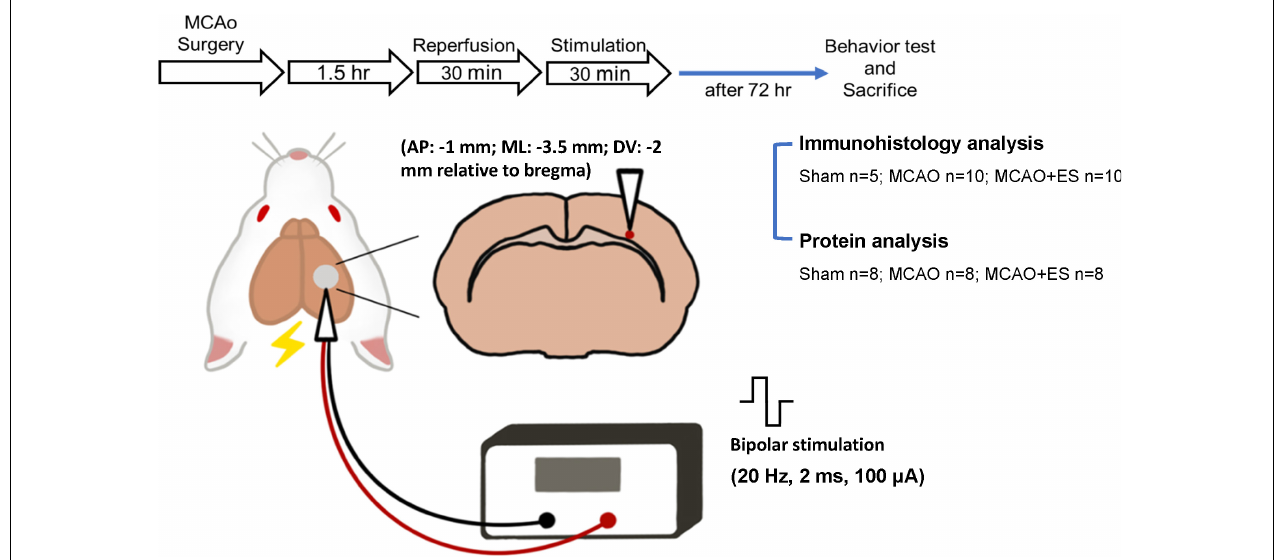
FIGURE 1 | Schematic diagram of the primary somatosensory (S1) cortical electrical stimulation (ES) experimental design. Rats sustained 90 min of transient middle cerebral artery occlusion (tMCAO) or sham operation, and electrodes were implanted to the S1 cortical area. Rats were randomly allocated to three groups and labeled as Sham (sham-operated), MCAO (tMCAO without treatment), and MCAO + ES (tMCAO with ES). A pair of electrodes was stereotactically inserted into the S1 cortex (1 mm posterior to bregma, 3.5 mm lateral to midline, and 2 mm depth) in 30 min after reperfusion. The ES-treated group received 30 min of biphasic direct current ES (frequency, 20 Hz; pulse length, 2 ms; stimulating amplitude, 100 µ A; biphasic pulse) after electrode implantation. Functional outcomes were evaluated 3 days after tMCAO, and animals were sacrificed for further